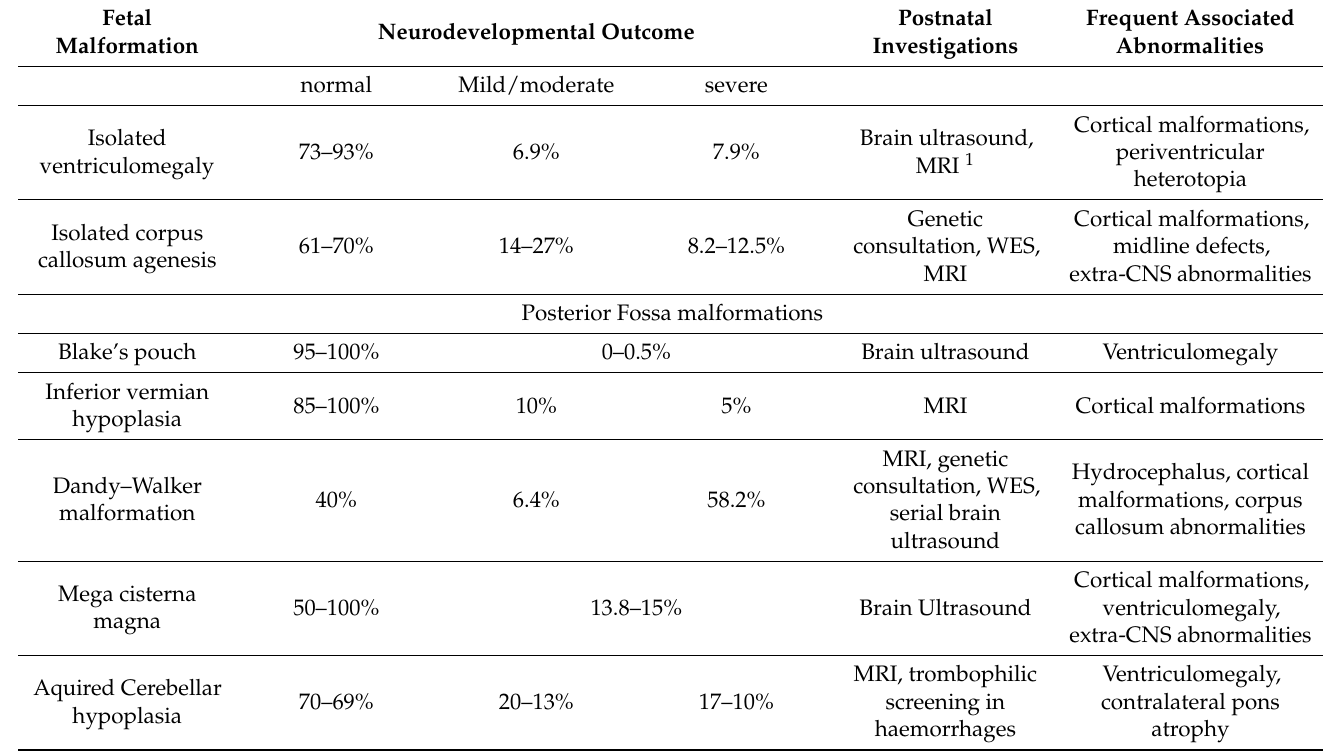
Table 1. Selected fetal CNS malformations: neurodevelopmental outcome